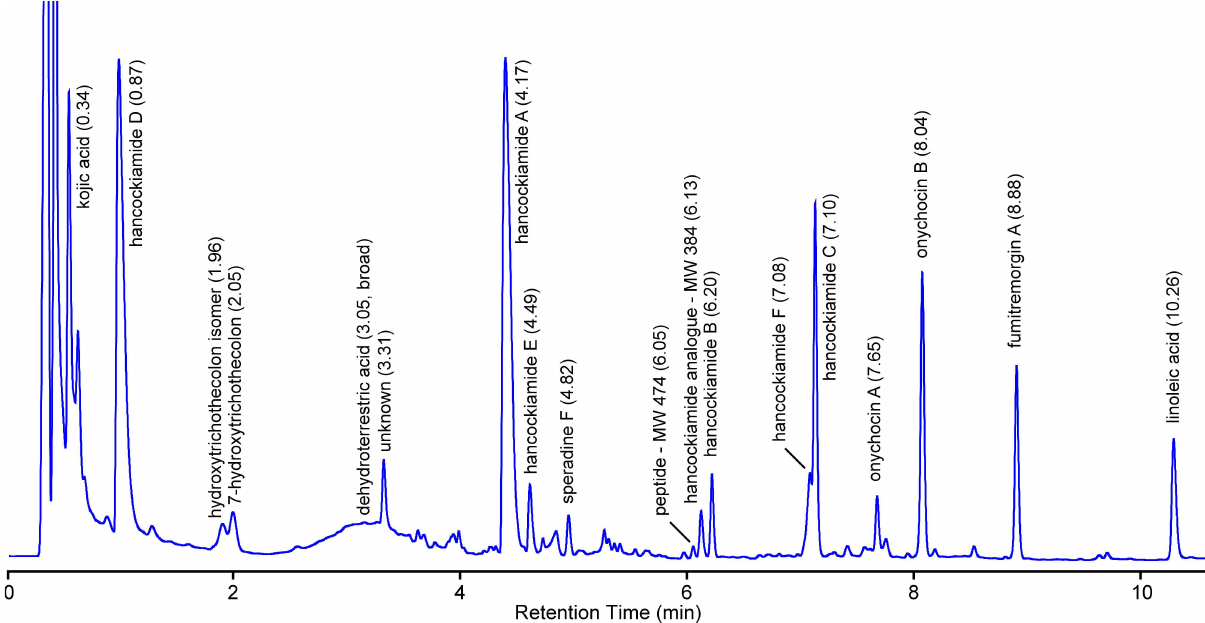
Fig 2. HPLC profile (210 nm) of Aspergillus hancockii after cultivation on rice for 21